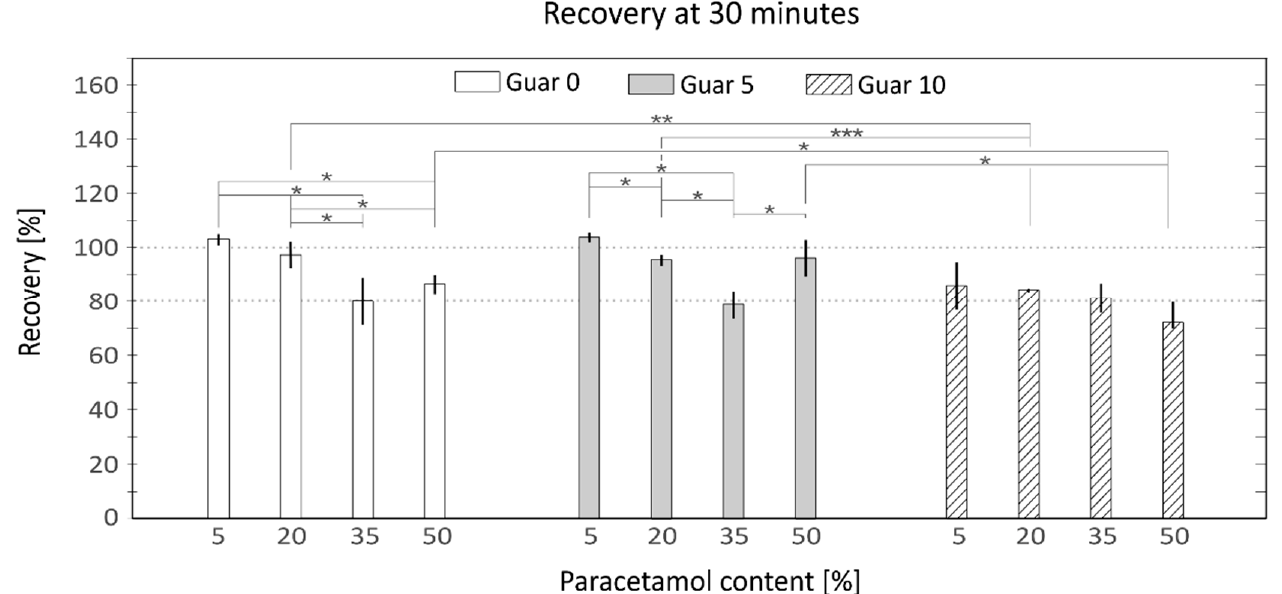
Figure 2. Recovery percentages of each API containing mixture grouped by Guar gum content, white columns 0% wt; Grey columns 5% wt and Striped columns 10% wt of Guar Gum. Horizontal axis represents the percentage of paracetamol, 5, 20, 35 and 50% wt and vertical axis the% rate of recovery measured with HPLC-DAD. (mean ± SD, n = 3 * p < 0.05, ** p < 0.01, *** p < 0.001).